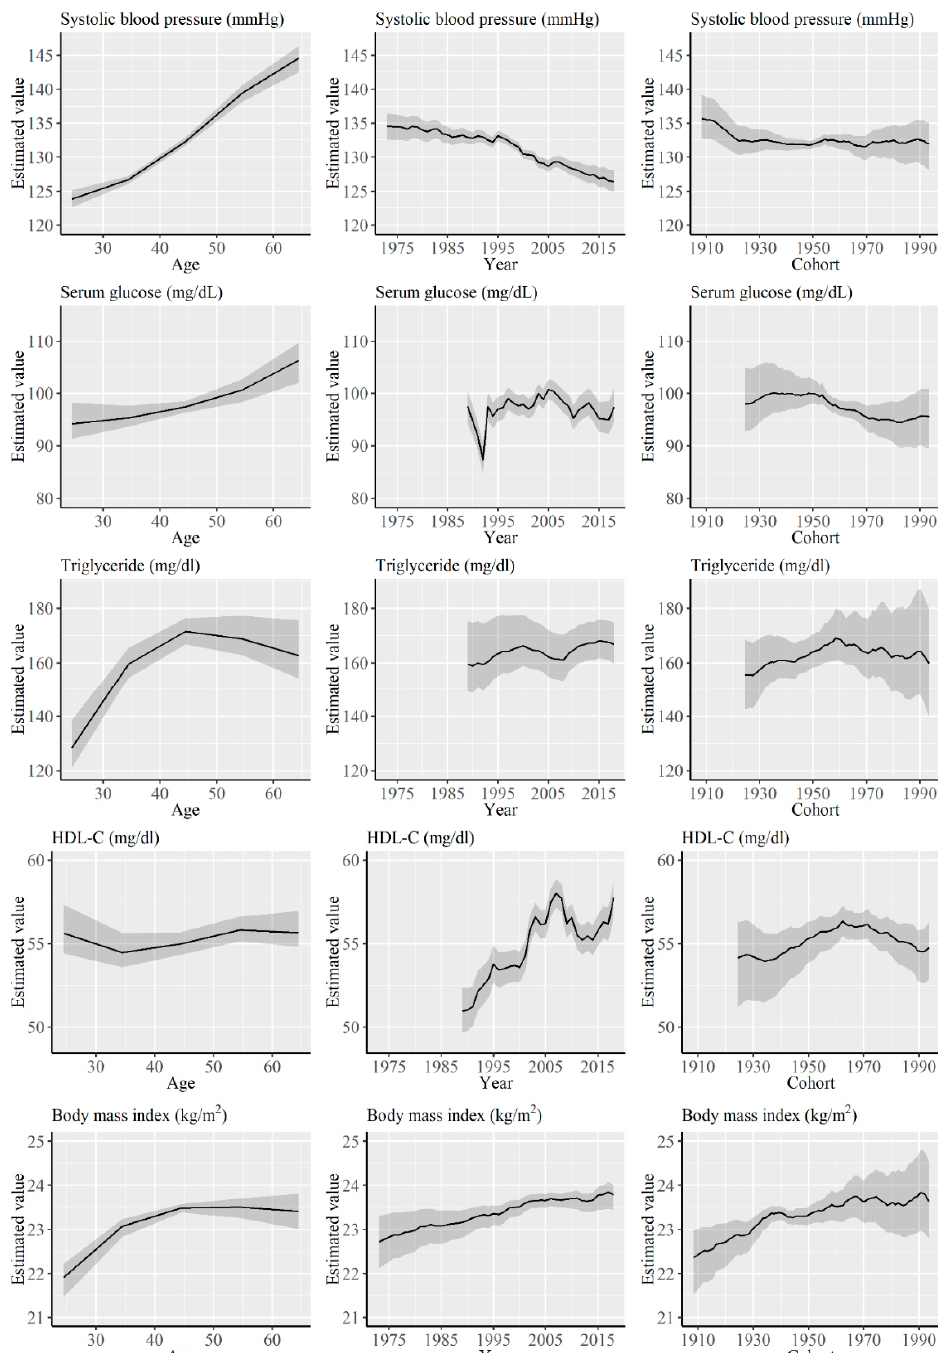
Figure 3. Results of the Age-Period-Cohort (APC) analysis of systolic blood pressure, serum glucose, triglyceride, high-density lipoprotein cholesterol, and body mass index for men. Solid lines signify estimates of each effect, and the shadings show 95% credible intervals of each estimates.